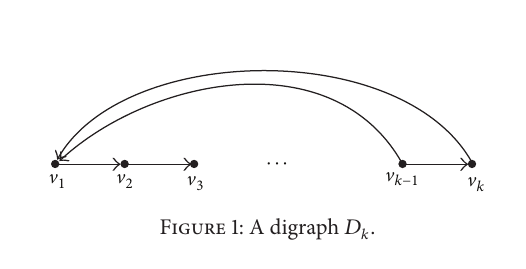
Figure 1: A digraph 𝐷 𝑘